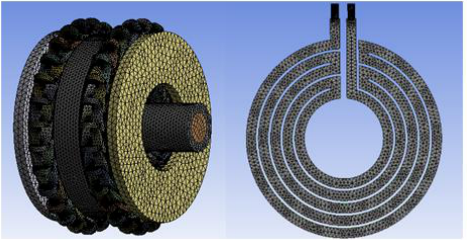
Figure 27. Schematic diagram of the prototype fluid-solid coupling simulation model.